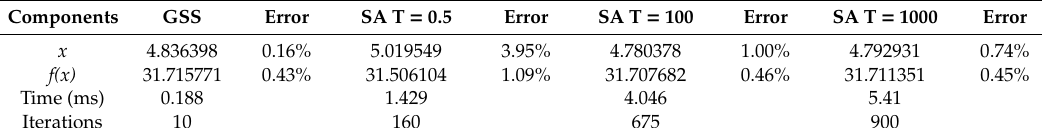
Table 5. Results of the algorithms for the test function 2.